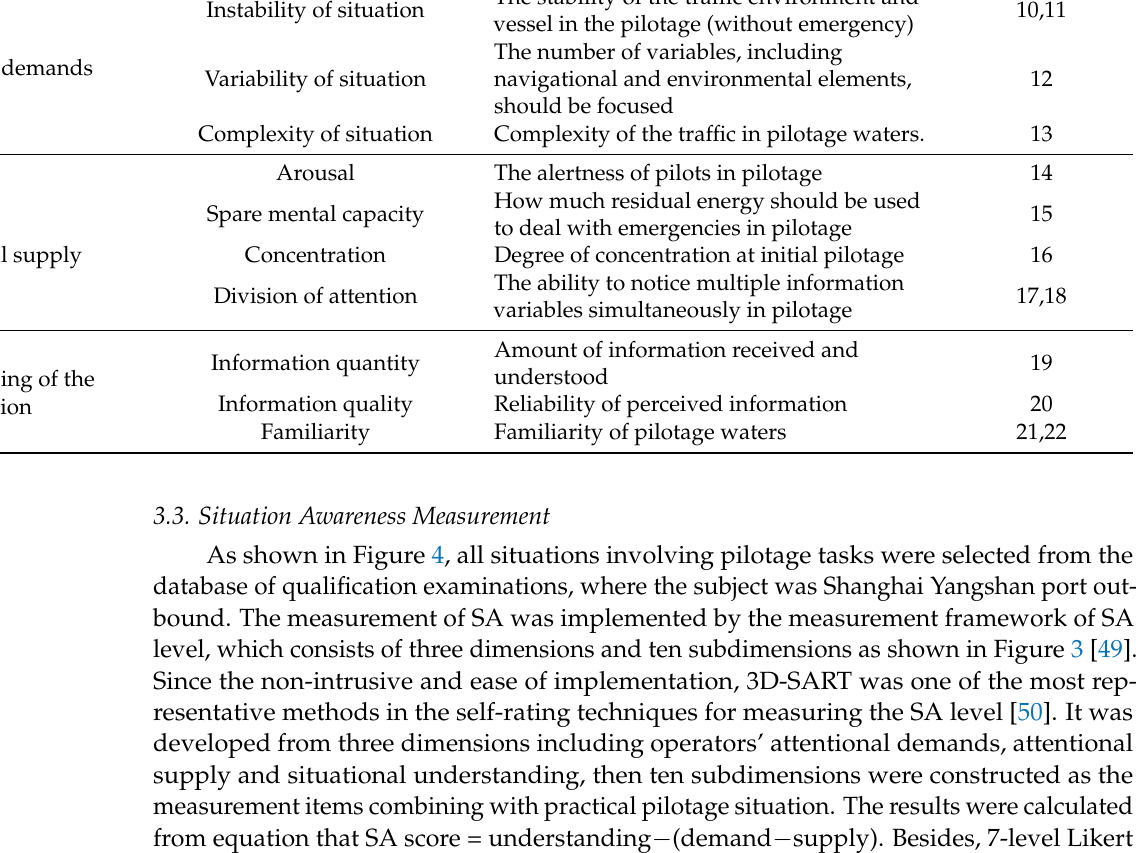
Table 2. Structure of pilot unsafe behaviors survey scale.